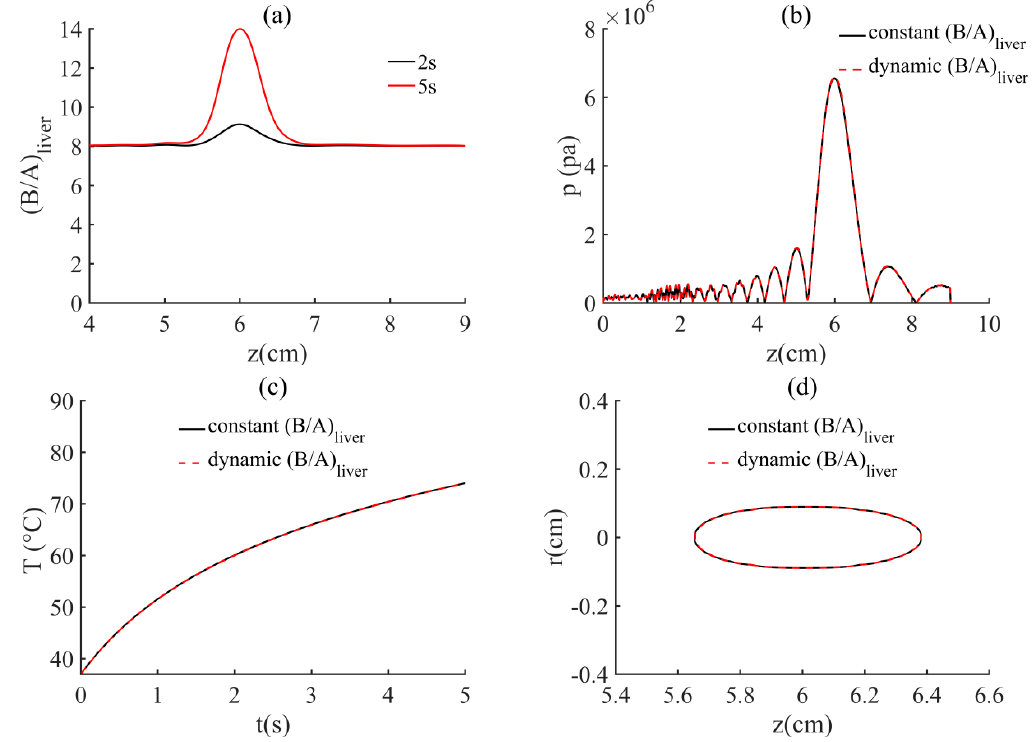
( ) AB at t = 2 s and 5 s. The effects of the dynamic non-linearity Figure 5. ( a ) The evolution of liver parameter on: ( b ) p and ( c ) T at the ultrasonic focus, and ( d ) the thermal damage zone at t = 5